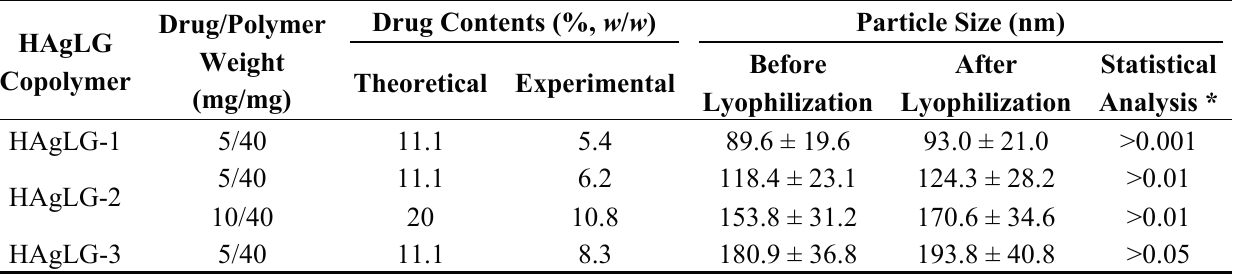
Table 2. Characterization of doxorubicin (DOX)-incorporated HAgLG polymeric micelles. Drug/Polymer HAgLG Copolymer